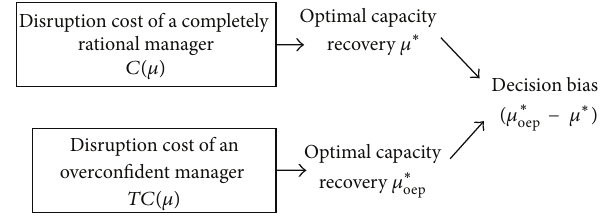
Figure 1: Decision bias model due to